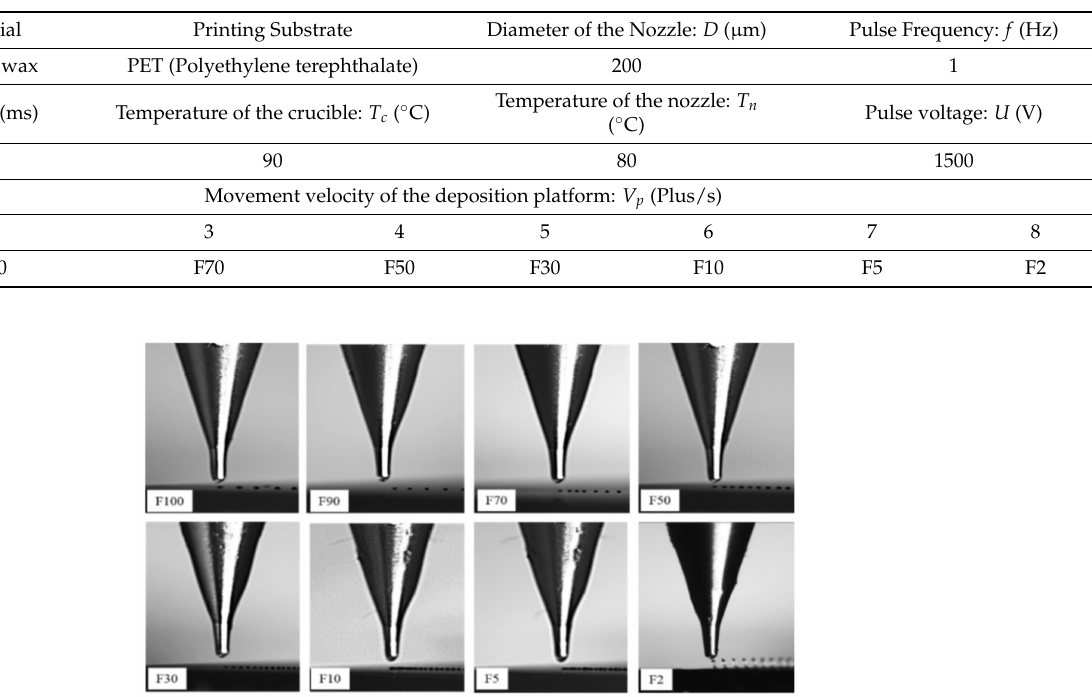
Table 2. Process parameters of droplet deposited lines.